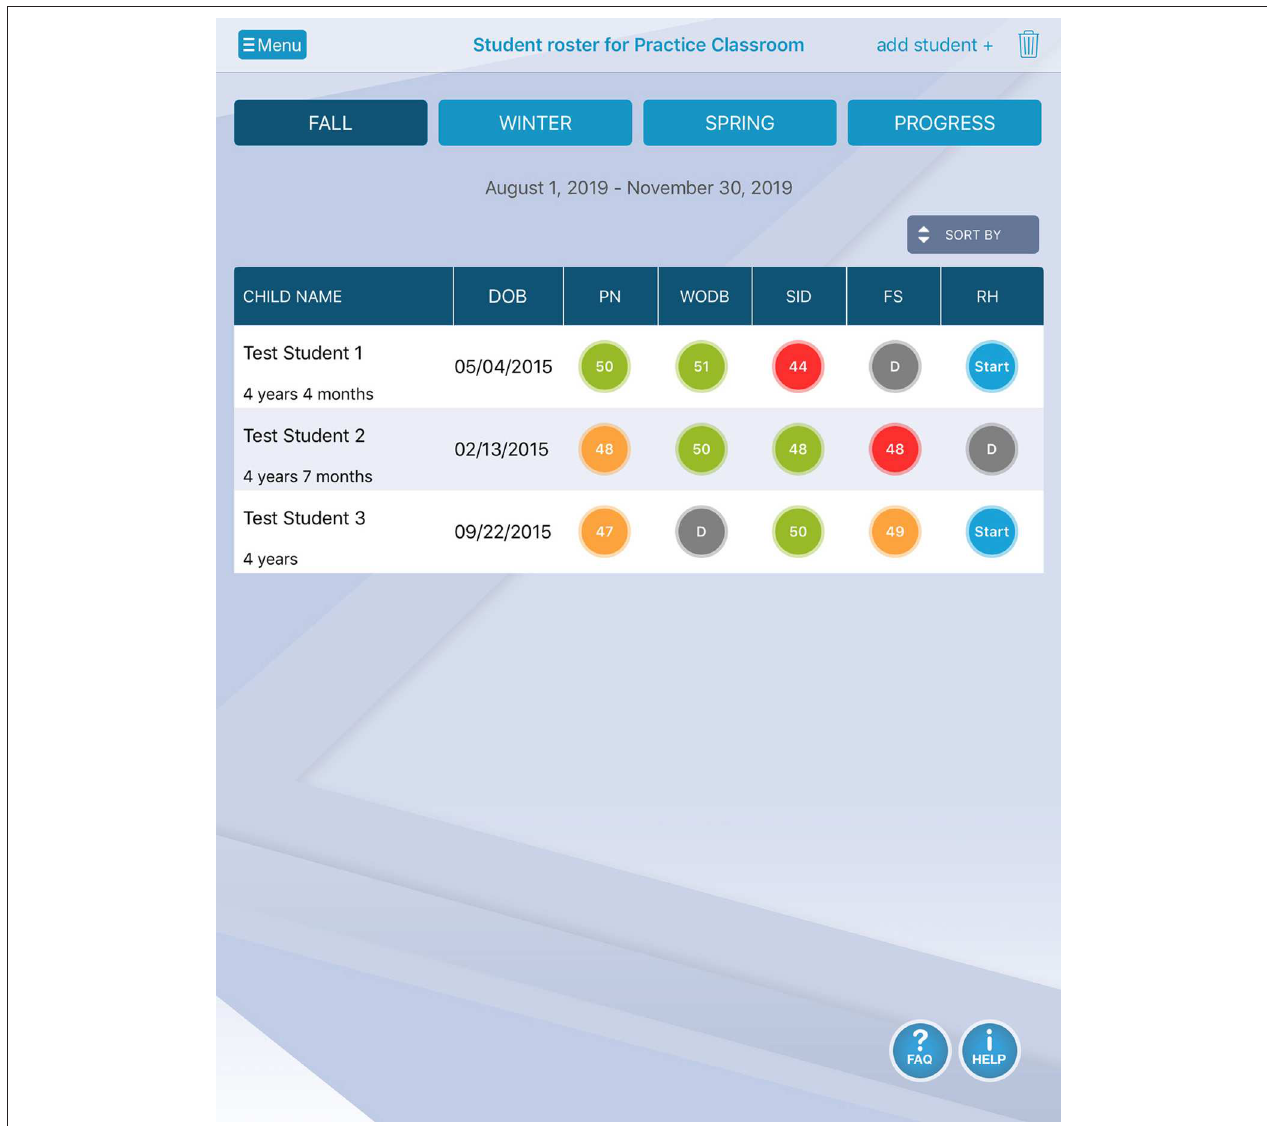
FIGURE 1 | Screenshot of the IGDI-APEL main classroom screen. It shows a list of students in the class with their scores and tier designations on the five early literacy and language